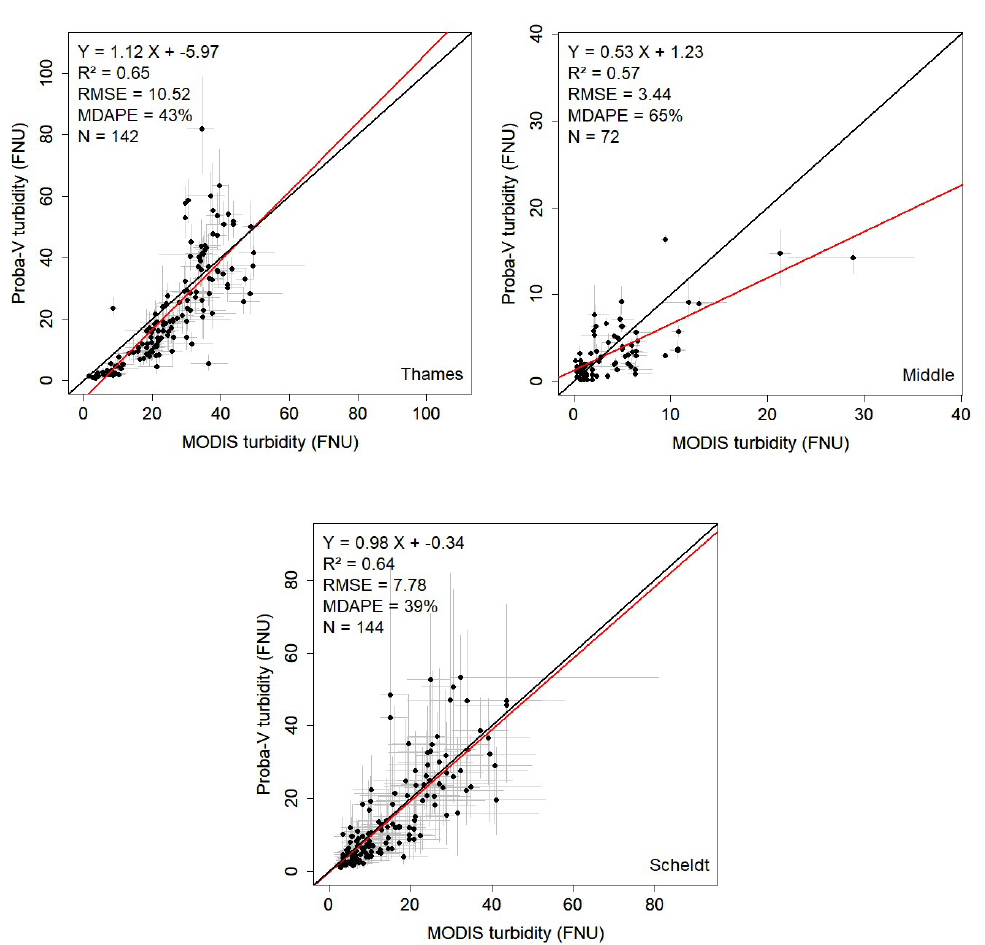
Figure 9. Scatterplots between PROBA-V and MODIS turbidity for the Thames outlet ( top left ), Middle of the North Sea ( top right ) and Scheldt outlet ( bottom ). The solid black line is the 1:1 line, the grey lines show the IQR. The red line is the linear regression line (R² = coefficient of determination, RMSE = Root Mean Square Error, MDAPE = Median Absolute Percentage Error and N = Number of observations).